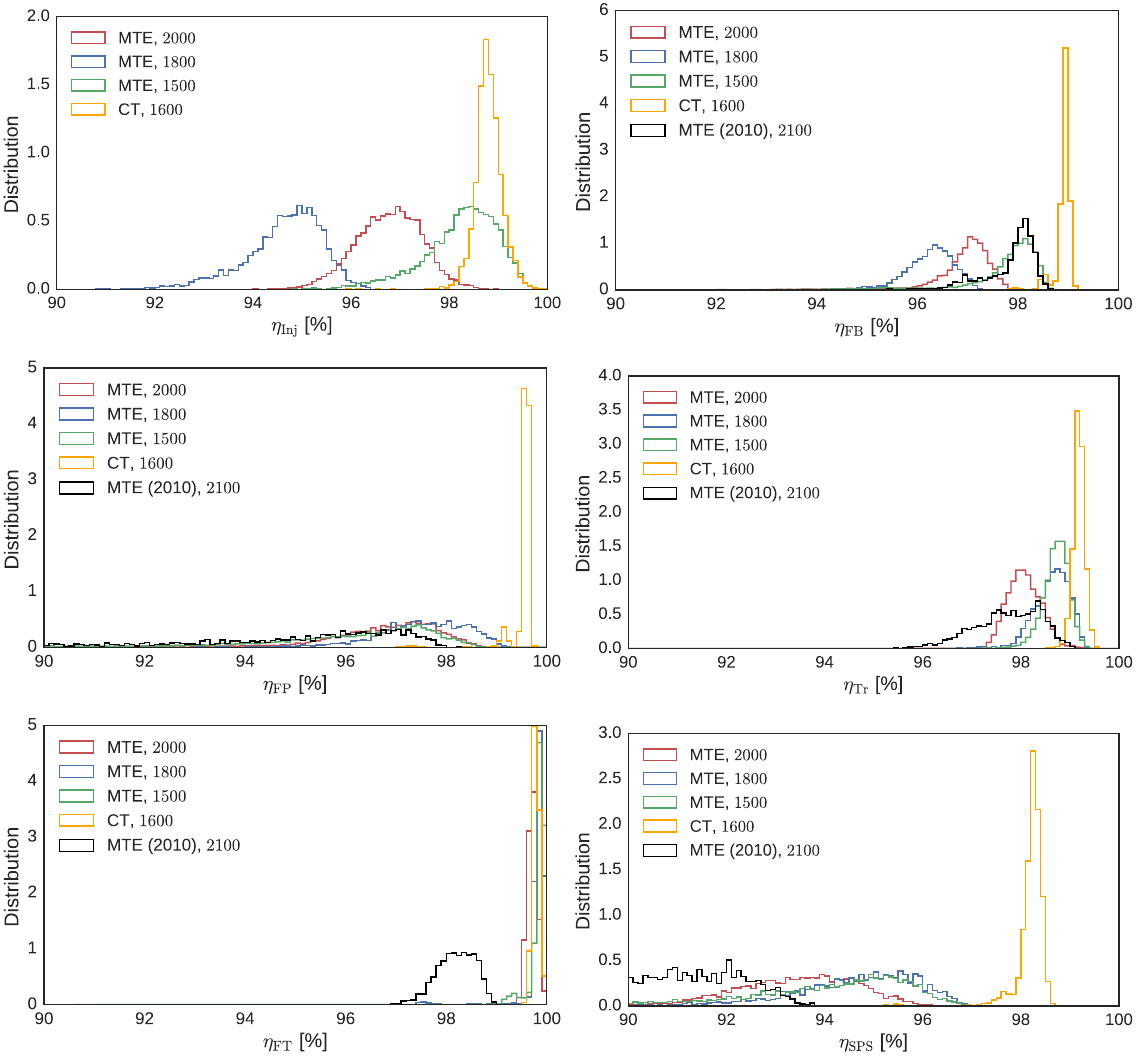
FIG. 15. Global picture of the distribution of the beam transmission through the SPS cycle at the key times used for the performance evaluation. The typical intensity values are in units of 10 10 ppp at extraction from the